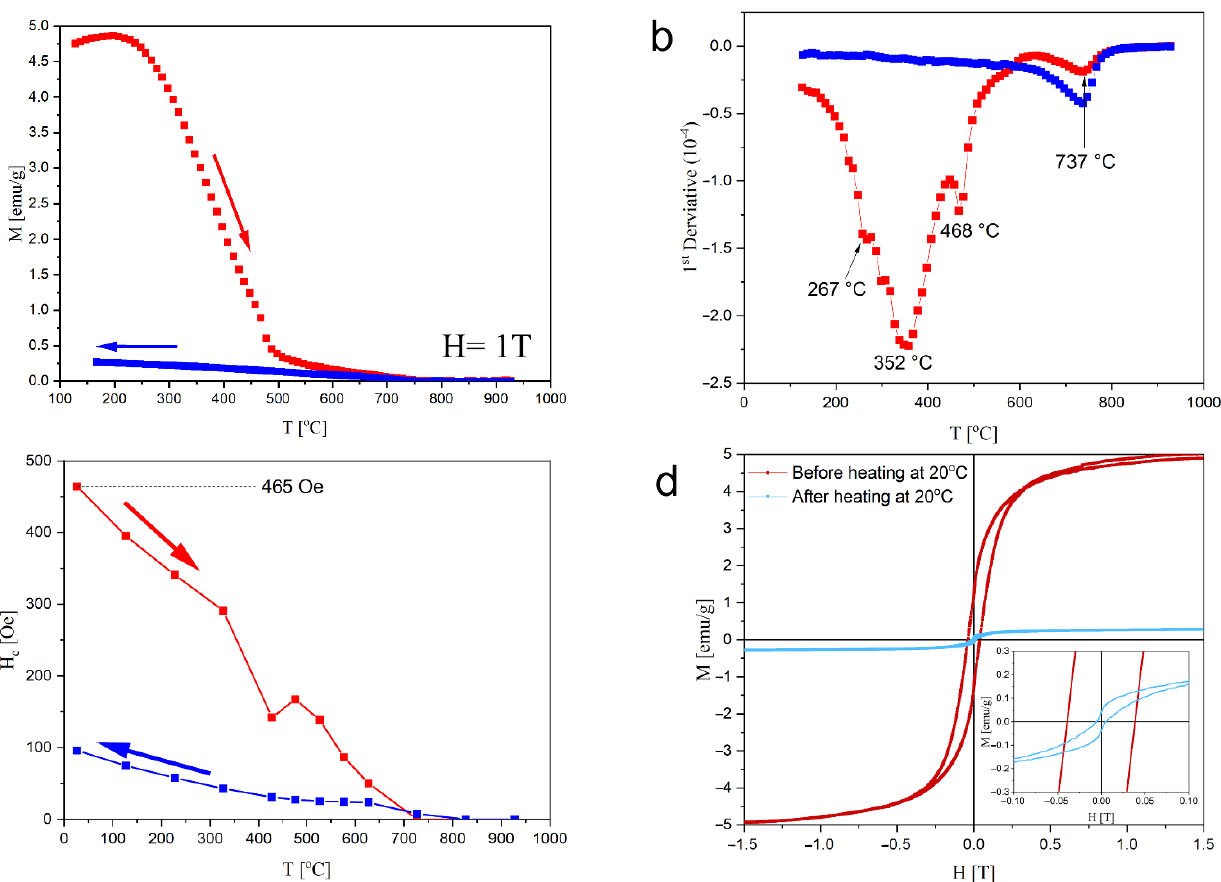
Figure 4. The temperature-dependent magnetization at 1 T for the amorphous phase ( a ); the derivative of the temperature-dependence used for the determination of the characteristic temperature ( b ); the thermal evolution of the magnetic coercivity ( c ); and the isothermal magnetization curves ( d ) before (red) and after heating (blue).